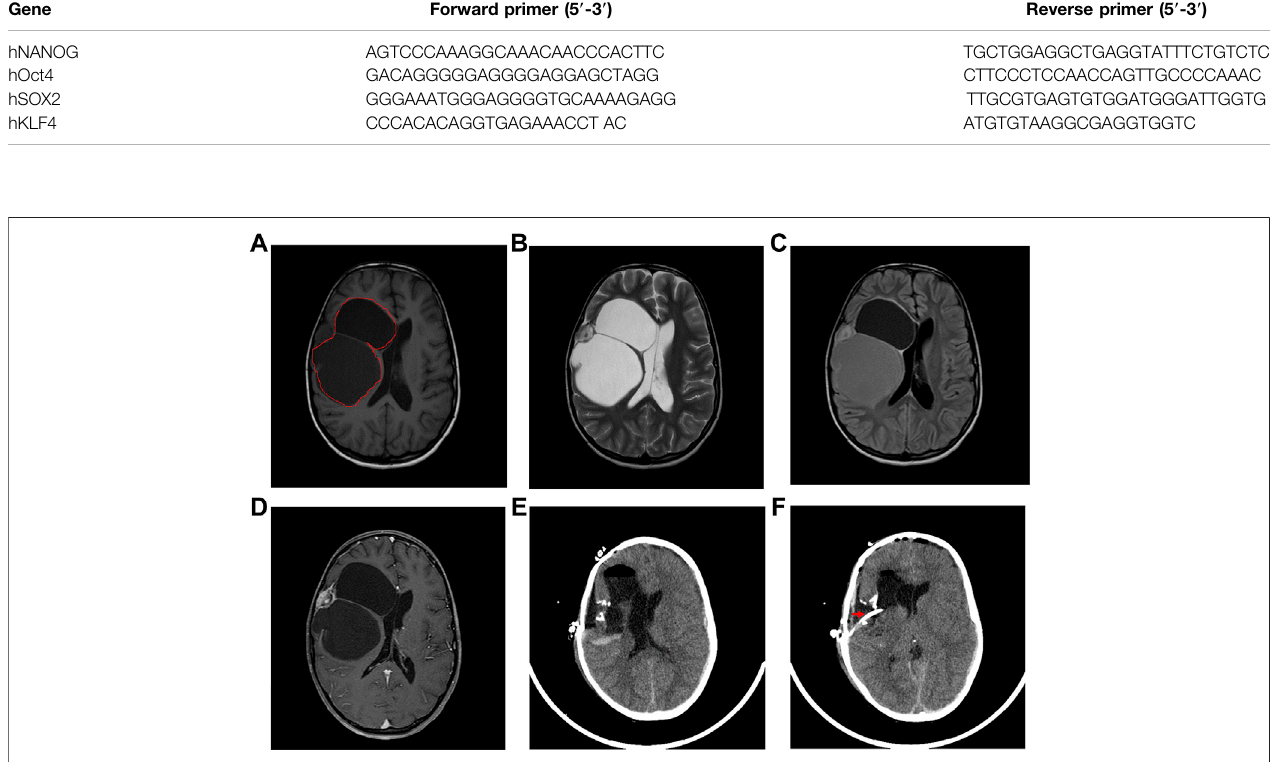
FIGURE1| Radiologicalfeaturesofthetumor. (A) ThetumorregionisdemarcatedusingredlinesinanAxialT-1weightedimage, (B) T-2weighted, (C) Flairand (D) T-1 contrast MRI showing a multiloculated tumor with solid and cystic areas causing mass effect on the ventricle with midline shift. (E) Post-operative axial CT scan showing tumor excision and decreased mass effect and return of midline structures. (F) Axial CT scan showing the catheter (marked by a red arrow) in the cystic cavity.